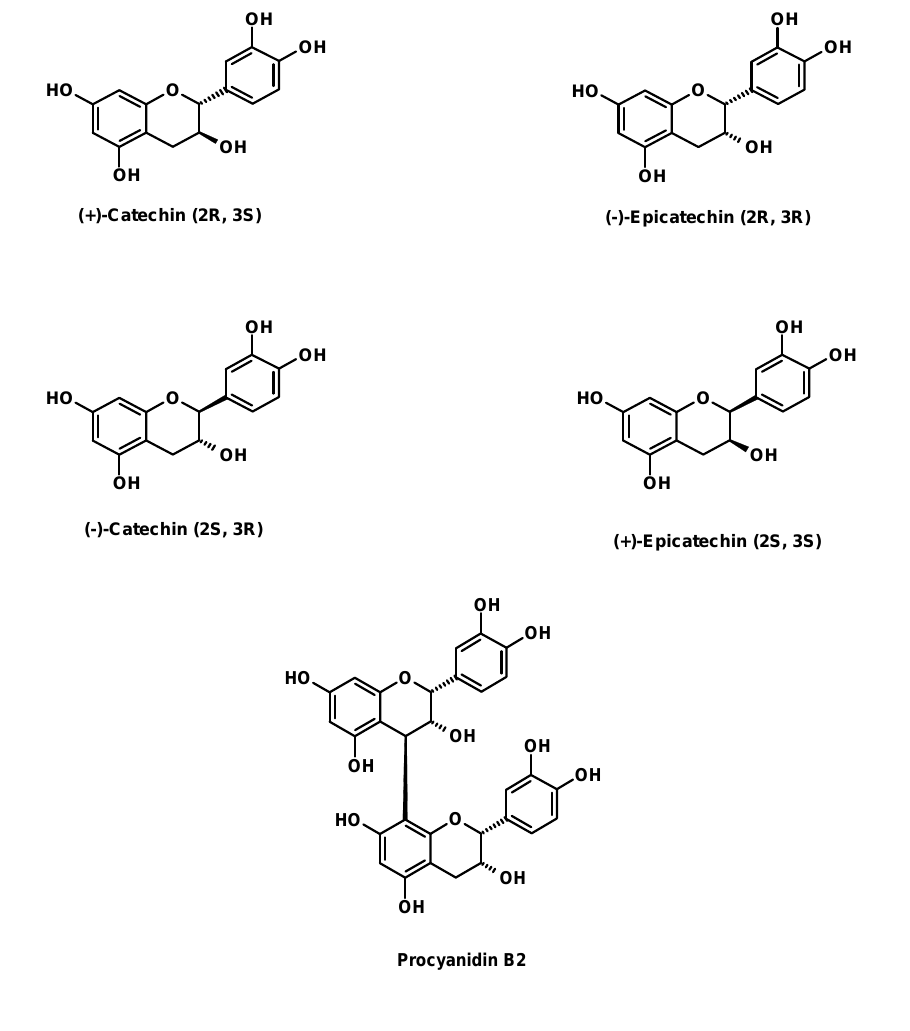
Figure 1. Structures of the catechin /epicatechin enantiomers and procyanidin